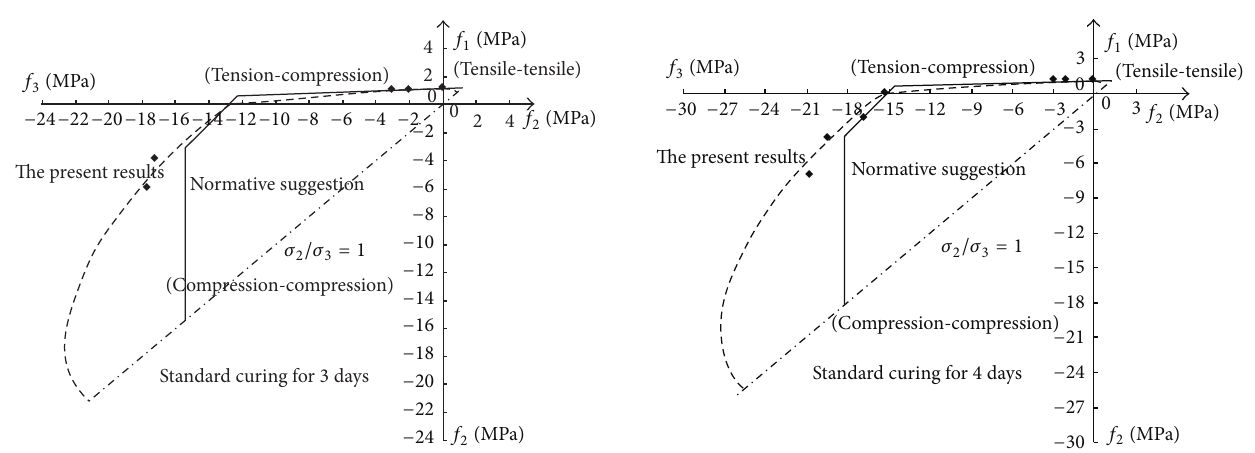
Figure 8: Biaxial ultimate strength envelope diagram of the C20 concrete after 4 d of standard